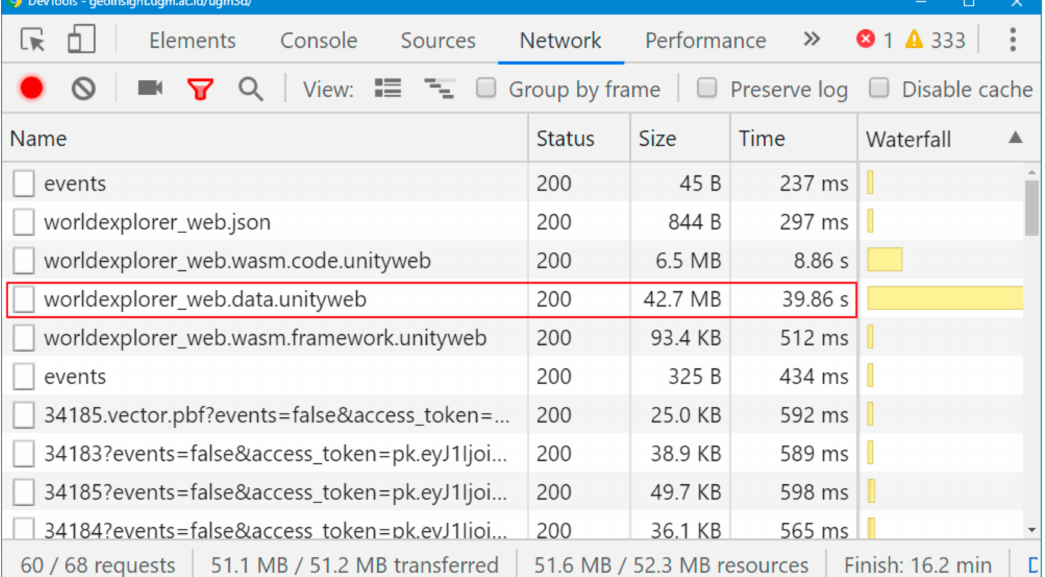
Figure 12. Chrome Dev Tools analysis of the WebGL performances.